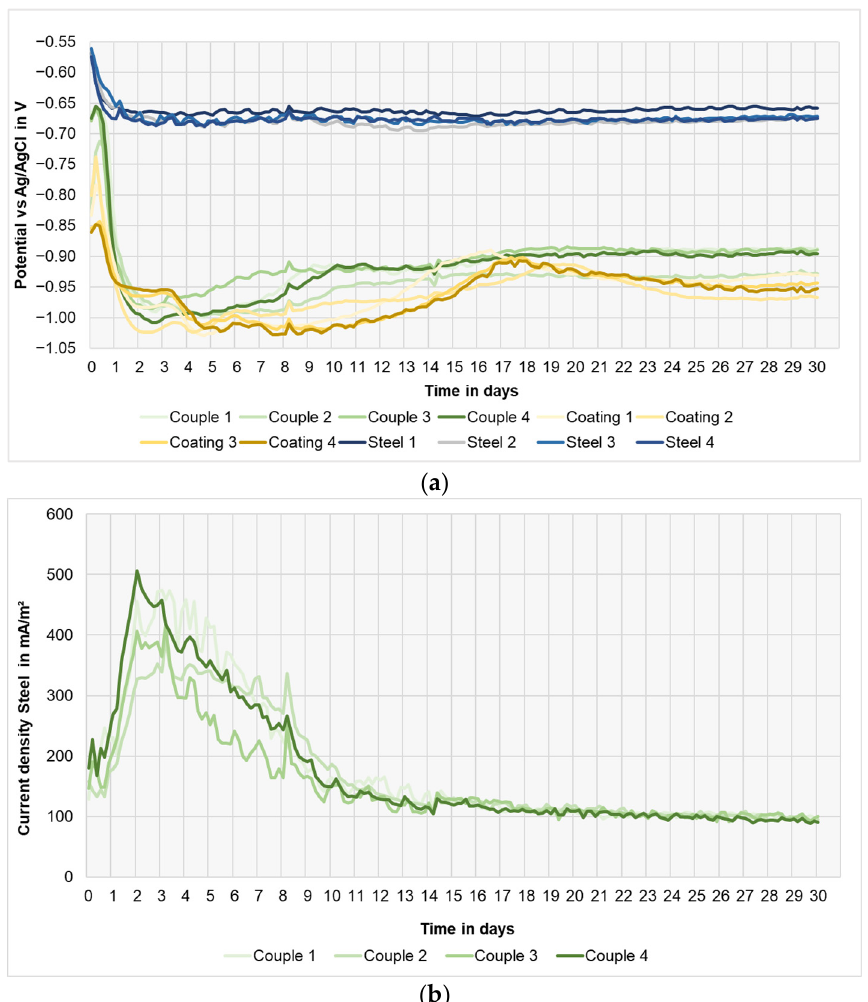
Figure 12. ( a ) OCP vs. Ag/AgCl of the single specimens and specimen couples over the test duration; ( b ) Galvanic current density of the thermal spray coated and bare steel specimen couples over exposure time.